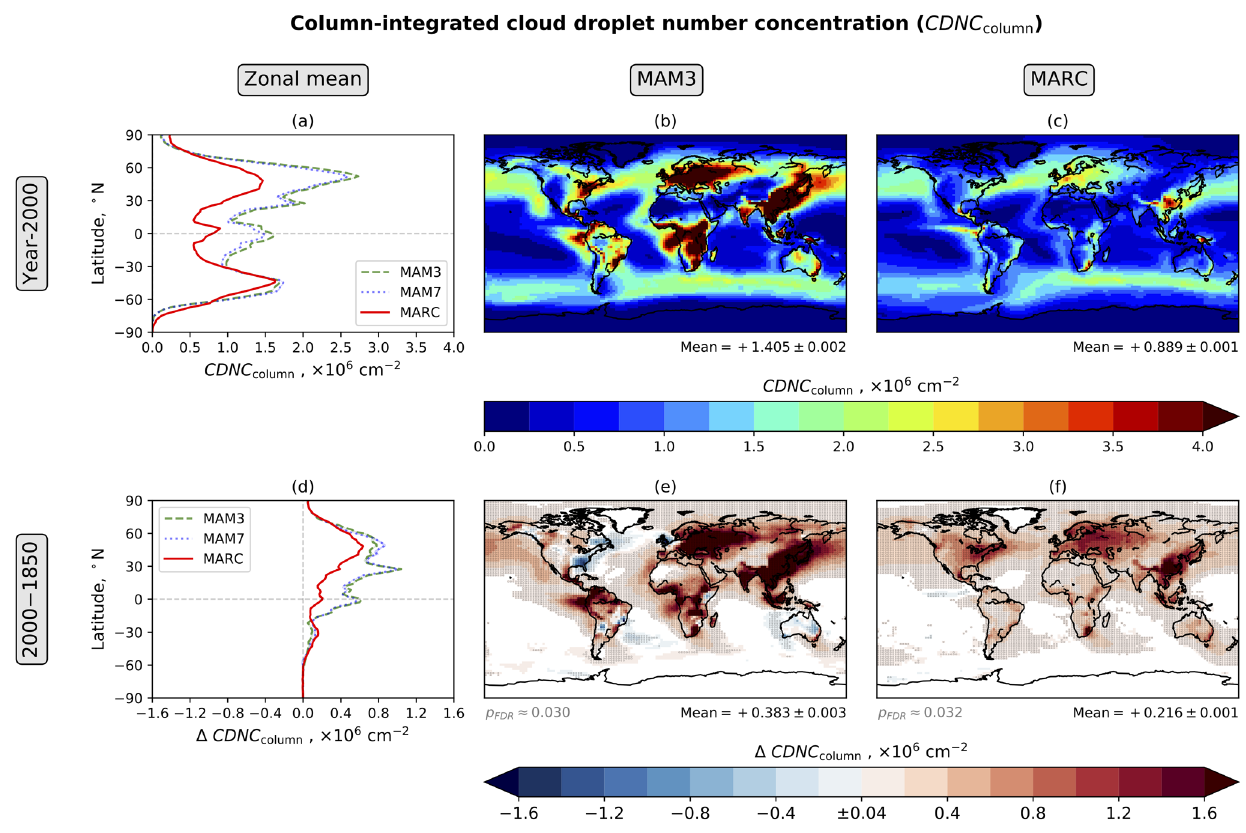
Figure 11. Annual mean column-integrated cloud droplet number concentration (CDNC column ). The figure components are explained in